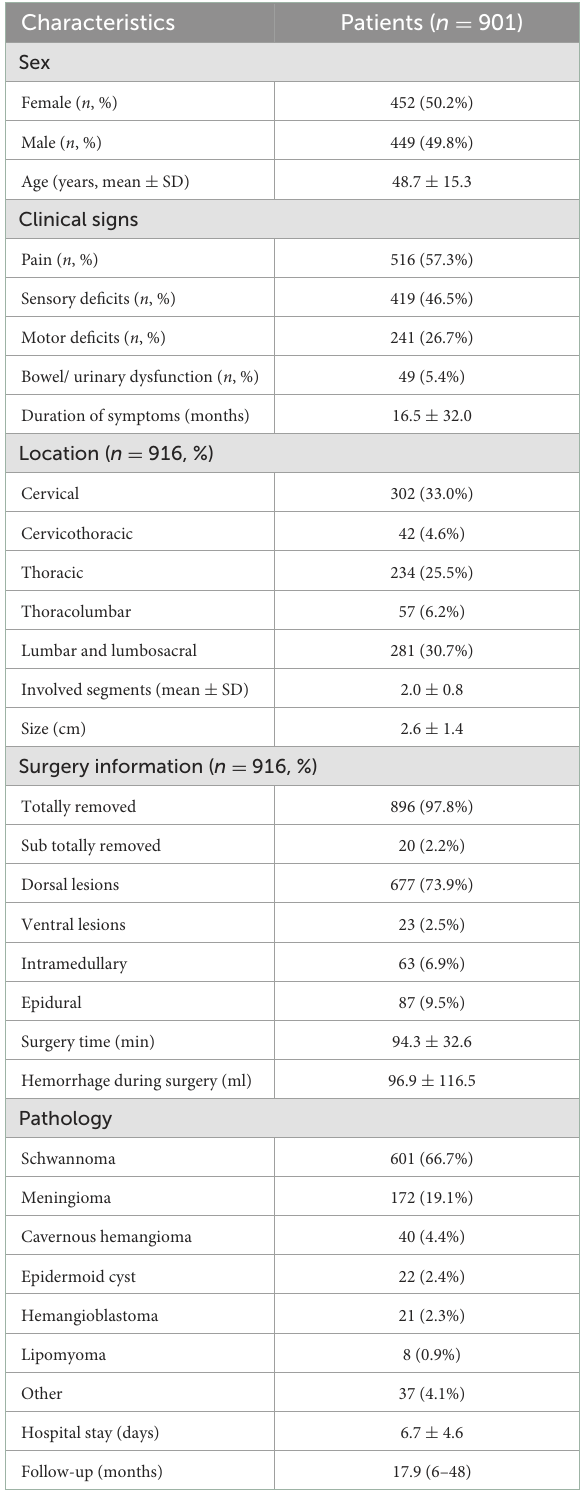
TABLE 1 General characteristics of patients.